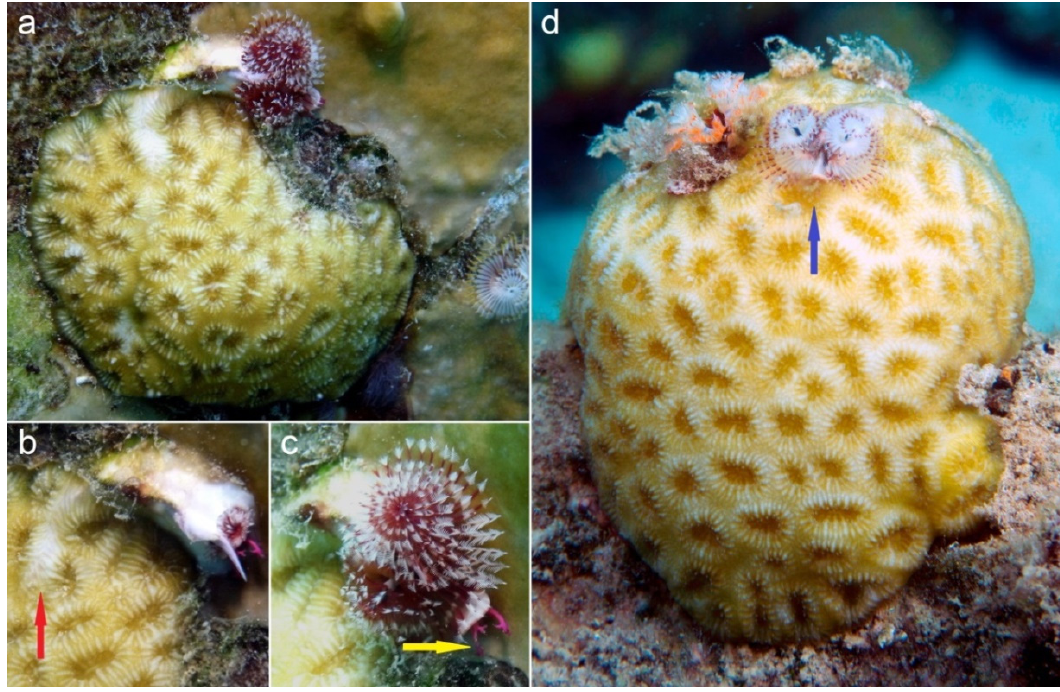
Figure 1. A coral of Pseudodiploria clivosa at 2 m depth, Scubaqua house reef (17°28'56" N 62°59'20" W), St. Eustatius, Eastern Caribbean (2015) hosting Spirobranchus giganteus : ( a ) overall view and ( b ) close-up.